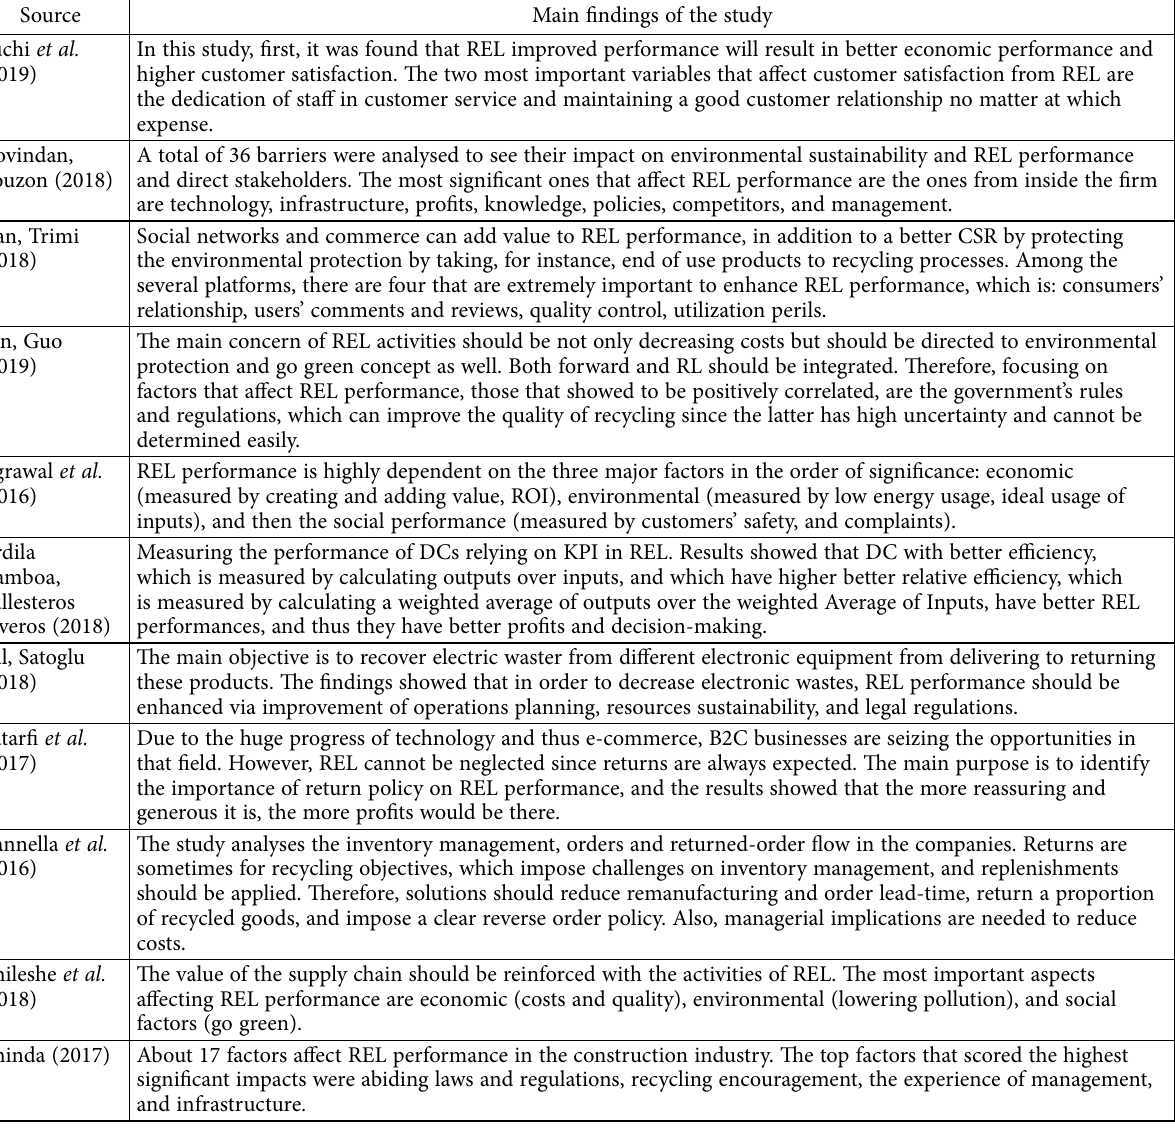
Table 3. Main findings in REL field (source: compiled by